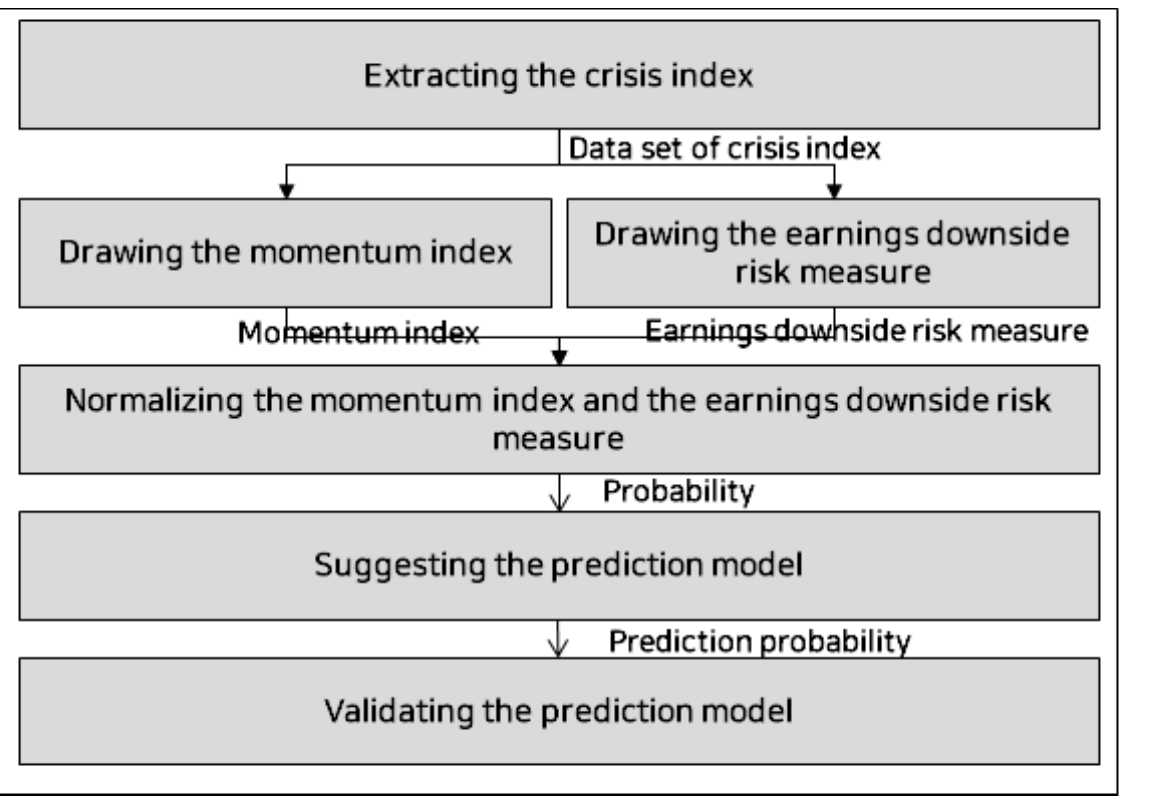
Figure 1. The framework of the proposed model for Crisis Index prediction.